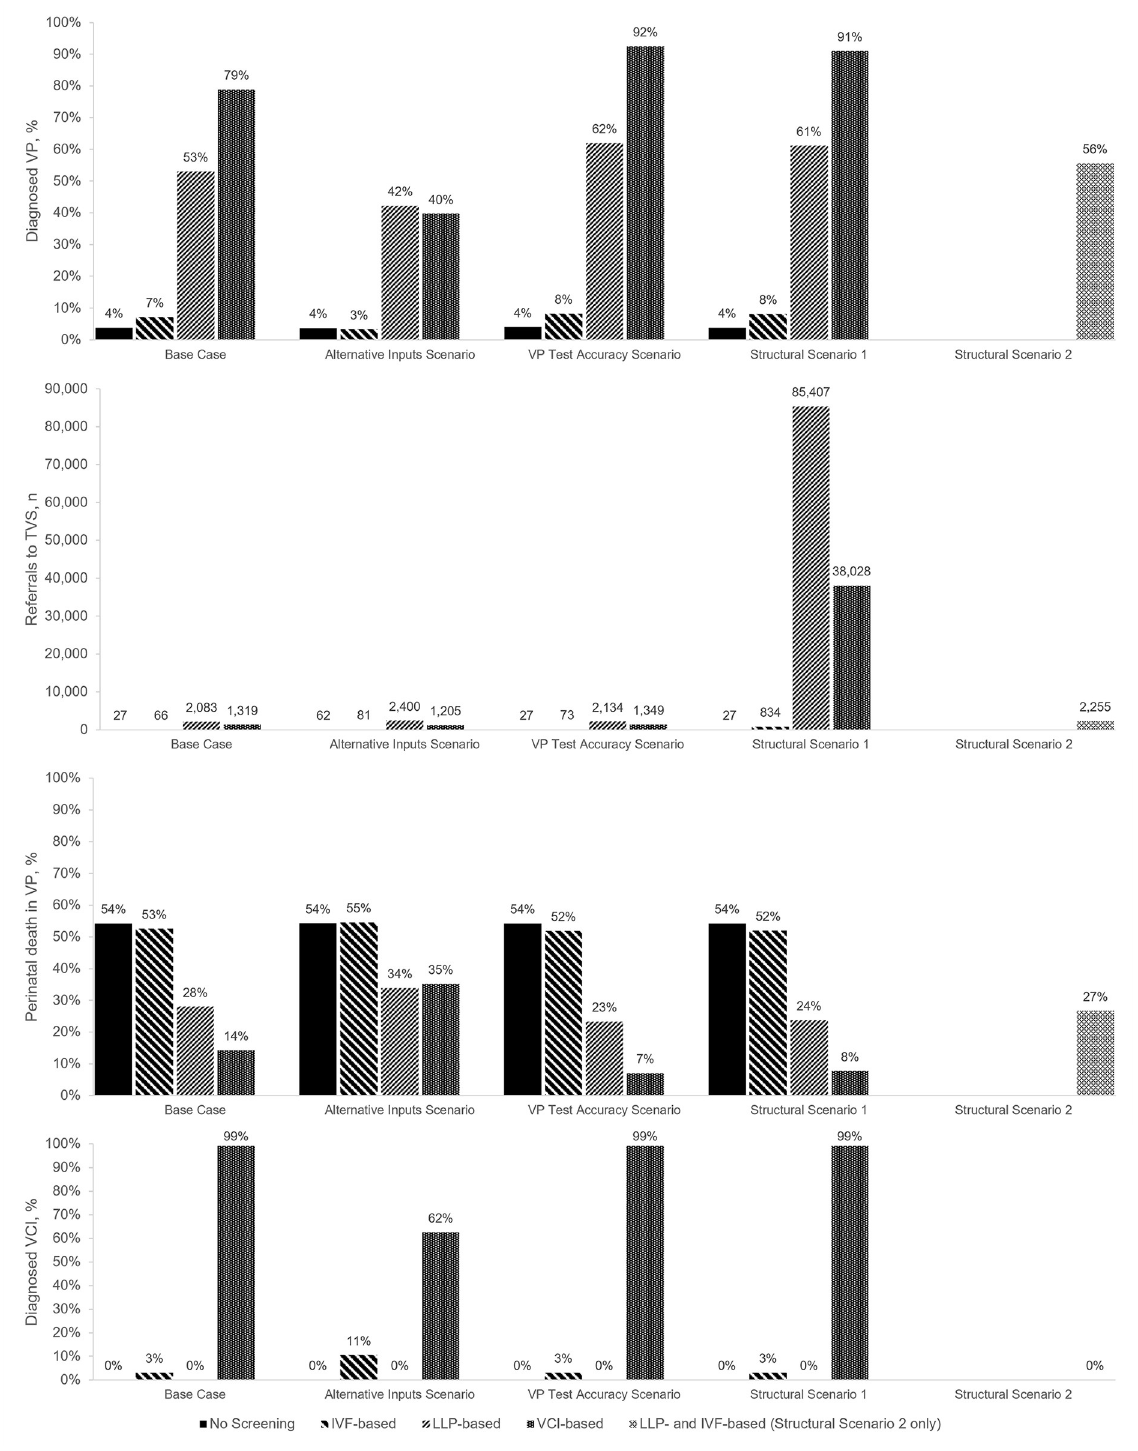
Fig 5. Results of scenario analyses. Alternative Inputs Scenario: Incorporation of alternative inputs based on alternate literature values. VP Test Accuracy Scenario: Higher test sensitivity for TAS and TVS for VP. Structural Scenario 1: Removal of TAS for VP at 32 weeks. Structural Scenario 2 : Combined IVF- and LLP-based pathway. Abbreviations: BL/S, bilobed or succenturiate; IVF, in vitro fertilisation; LLP, low-lying placenta; TAS, transabdominal sonography; TVS, transvaginal sonography; UKOSS, UK Obstetric Surveillance System; VCI, velamentous cord insertion; VP, vasa